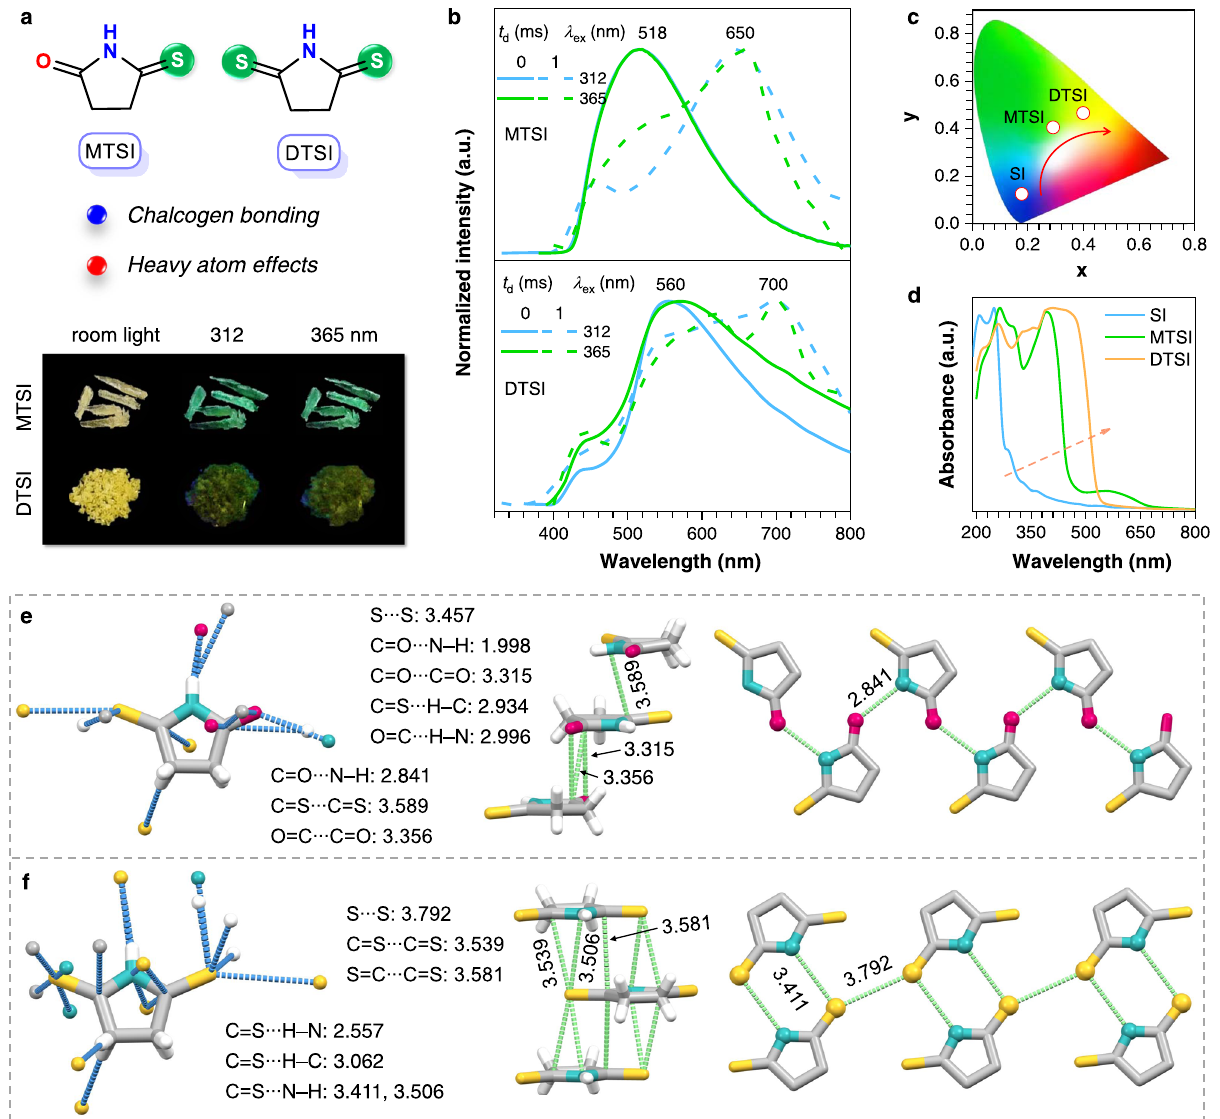
Fig. 6 Structure and photophysical properties of MTSI and DTSI single crystals. a Photographs taken under room light or varying UV lights and b prompt ( t d = 0 ms) and delayed ( t d = 1 ms) emission spectra with varying λ ex s of MTSI and DTSI single crystals. c CIE coordinate diagram of the prompt emission spectra ( λ ex = 312 nm) for SI, MTSI, and DTSI single crystals. d Absorption of SI, MTSI, and DTSI single crystals. e , f Single-crystal structure with denoted intermolecular interactions and fragmental molecular packing with denoted short contacts among electron-rich units of e MTSI and f